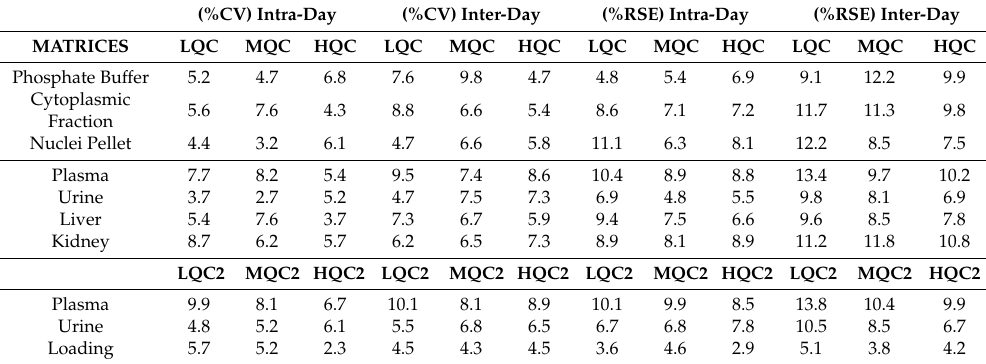
Table 2. Intra- and inter-day precision (%CV) and accuracy (%RSE) of Ola in different bio-matrices for normal (LQC, MQC, and HQC) and diluted samples (LQC2, MQC2, and HQC2). (%CV)